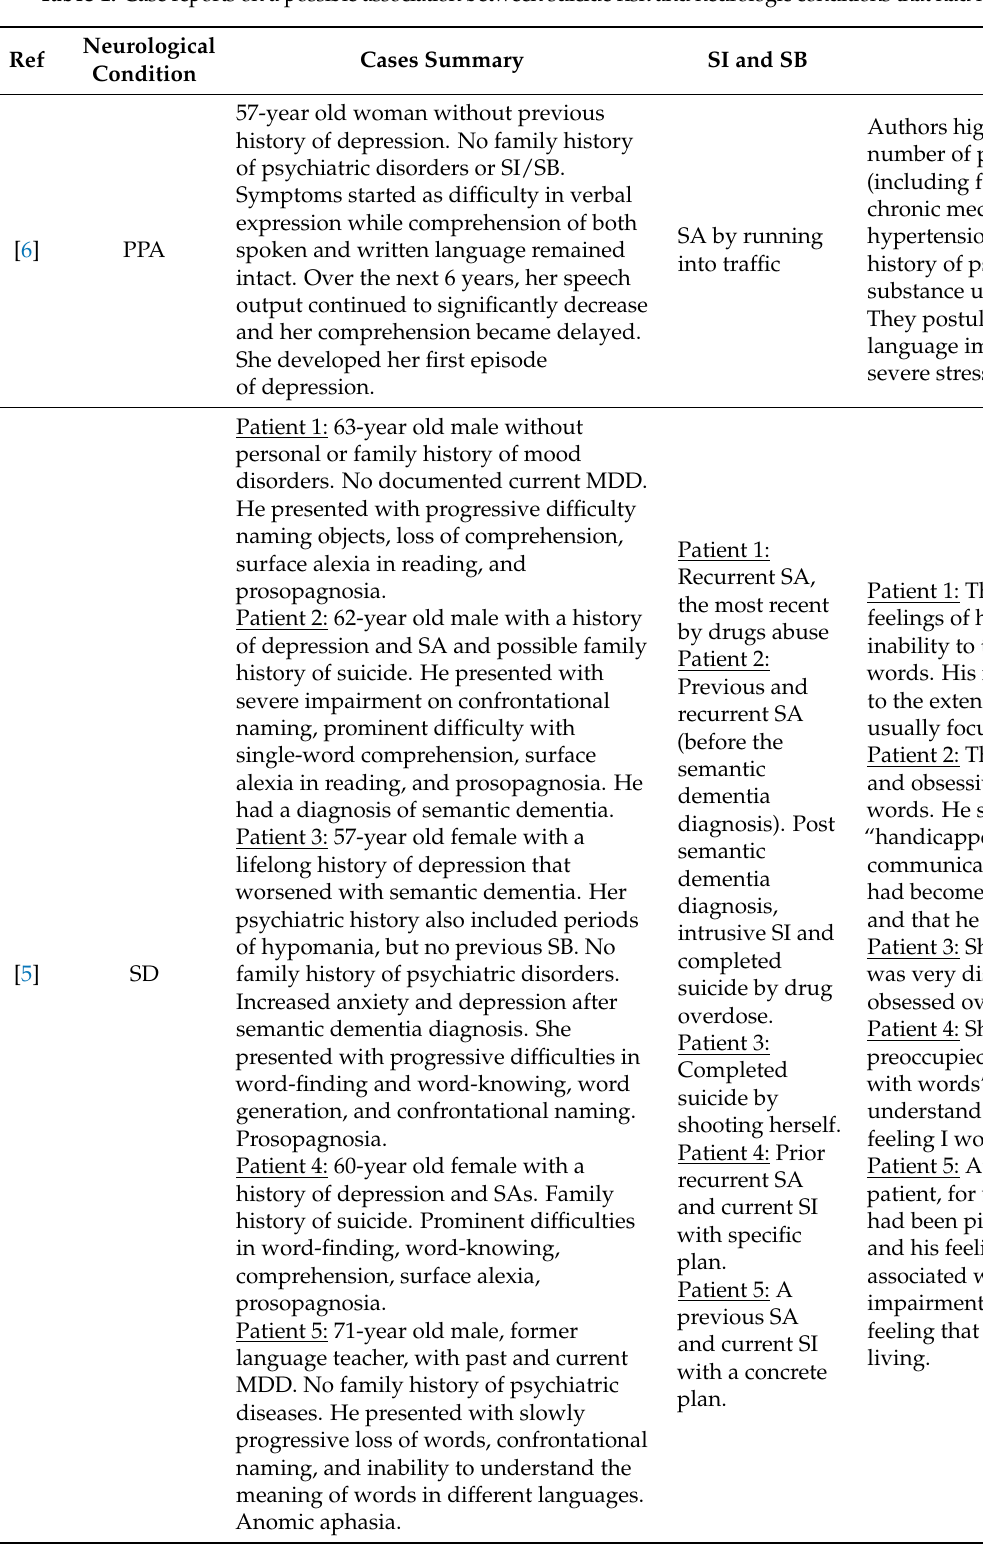
Table 1. Case reports on a possible association between suicide risk and neurologic conditions that had led to language